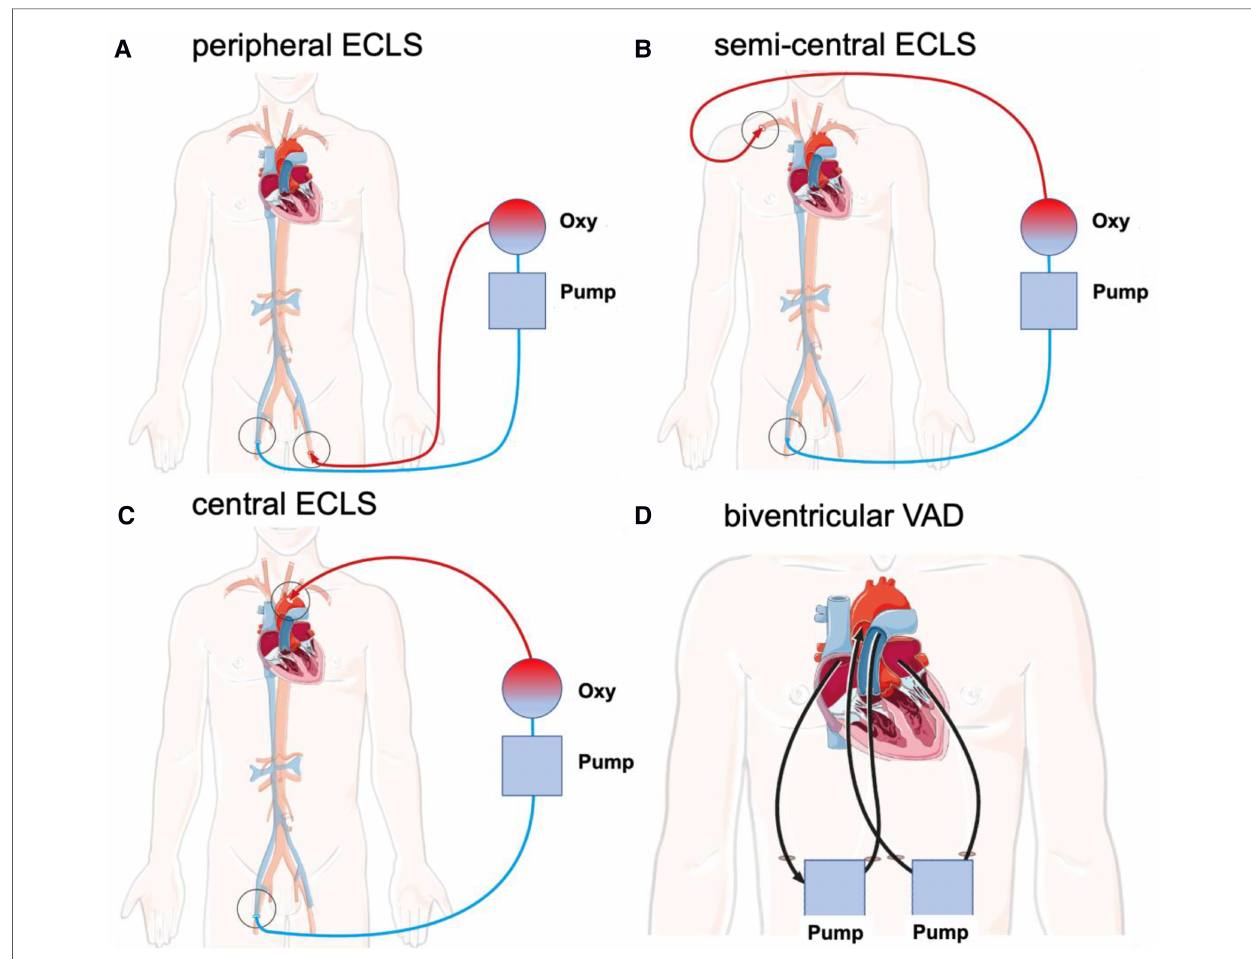
FIGURE 1 Schematic illustration of different cannulation techniques for interventional and surgical ECLS in adults as recommended by the ELSO. Deoxygenated blood (blue) is drained via the venous cannula under negative pressure. Blood is transferred through an oxygenator and oxygenated blood (red) is returned via the arterial cannula. ( A ) Peripheral ECLS. Insertion: Out fl ow via the femoral vein with in fl ow via the femoral artery (unilateral or bilateral). ( B ) Semicentral ECLS. Insertion: Out fl ow via the femoral vein or right atrium with in fl ow via the subclavian or axillary artery. ( C ) Central ECLS. Insertion: Out fl ow via the femoral vein or right atrium with in fl ow via the ascending aorta. ( D ) Biventricular VAD. Insertion: One out fl ow via the right atrium with in fl ow through the pulmonary trunk and a second out fl ow via the left atrium with in fl ow via the ascending aorta. cECLS,